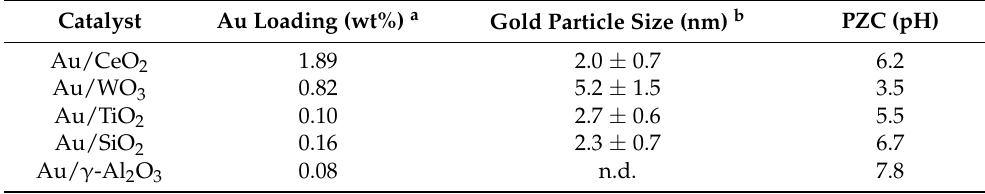
Table 1. Characteristics of the as prepared Au catalysts supported on different metal oxides.